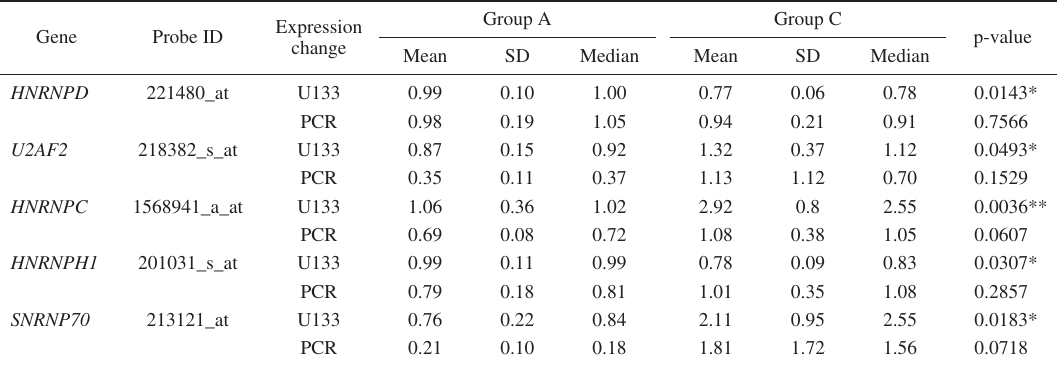
Table 2. Microarray and RT-PCR results for differences in splicing factor gene expression changes between Groups A and C after VPA treatment. Group Expression Probe ID change